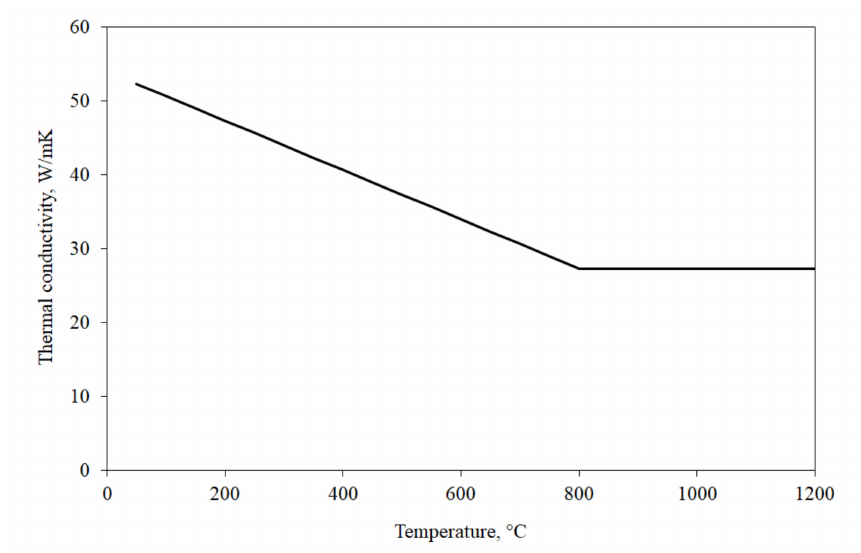
Figure 1. Thermal conductivity of steel.